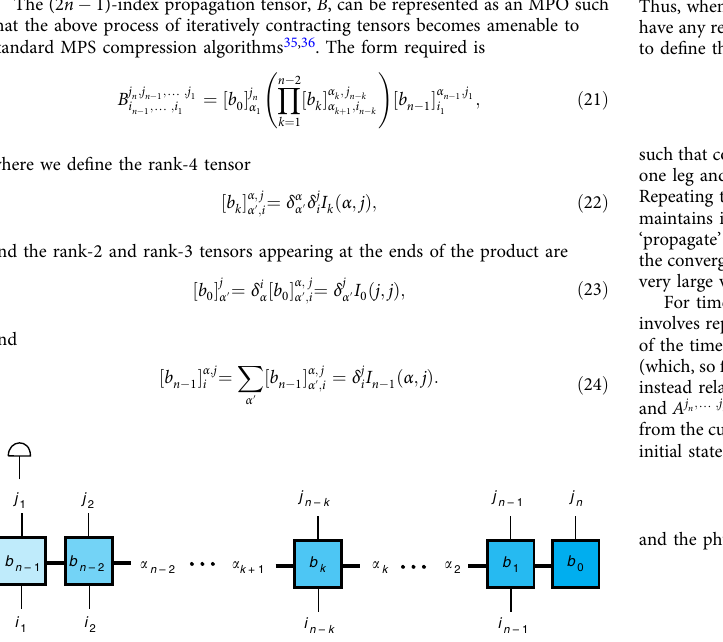
Fig. 5 Tensor network diagram depicting the MPO decomposition of the rank-(2 n + 1) tensor, B . The squares show the b k tensors in Eqs. (22) – (24), with k increasing right to left. The i n and j n tensor indices correspond to the vertical legs with n increasing from left to right. When n = K the j 1 leg is summed over to give the rank-2 K propagation phase MPO, represented in the fi gure by contraction with a rank-1 object; the d 2 -dimensional vector whose elements are all equal to one